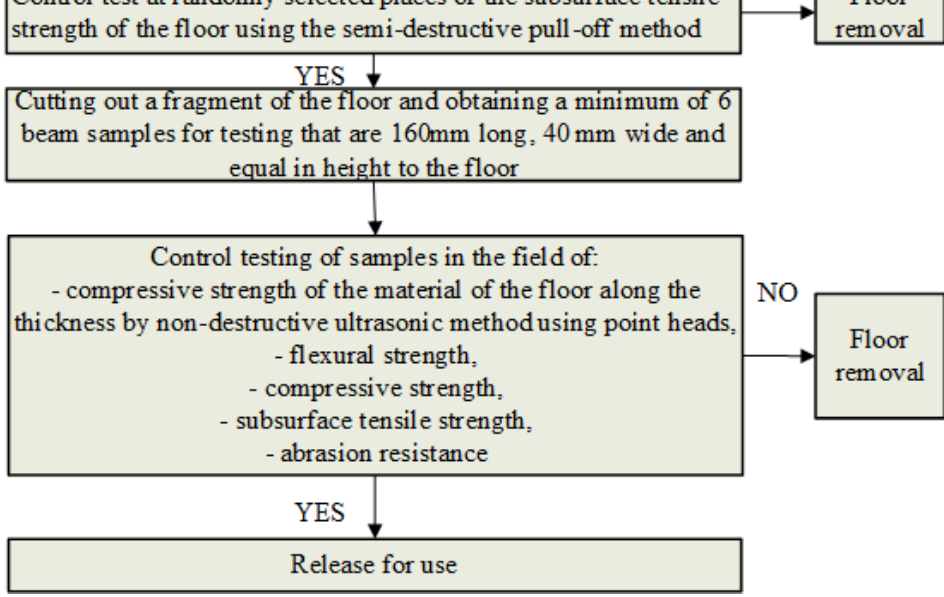
Figure 6. Control of the subsurface tensile strength of the floor using the pull-off method: ( a ) pull-off apparatus; ( b ) scheme of the method; ( c ) view of the glued steel disc; ( d ) view of the floor surface after the pull-off tests.